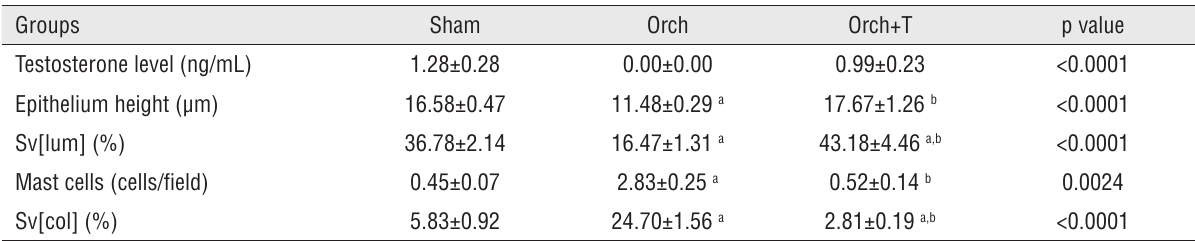
Table 1 - Hormonal and morphometric data of prostate from rats of groups Sham (n=8), hypogonadal (Orch) (n=8), and hypogonadal with hormonal replacement (Orch+T)